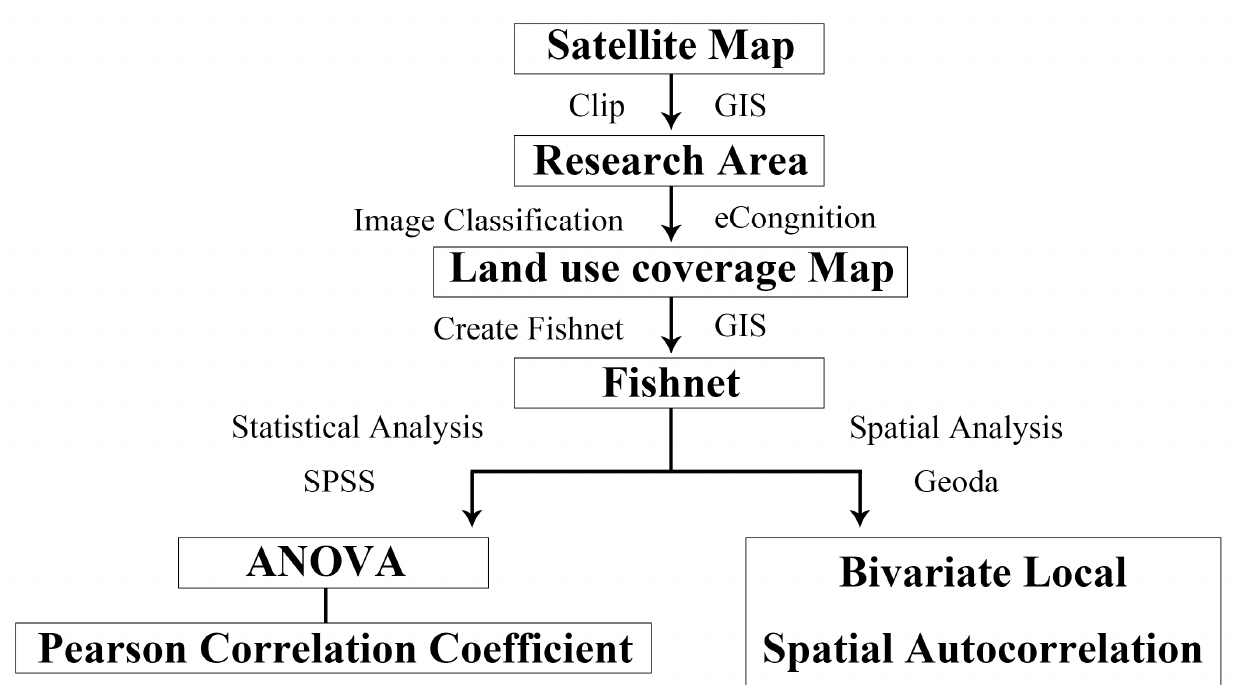
Figure 2. Research